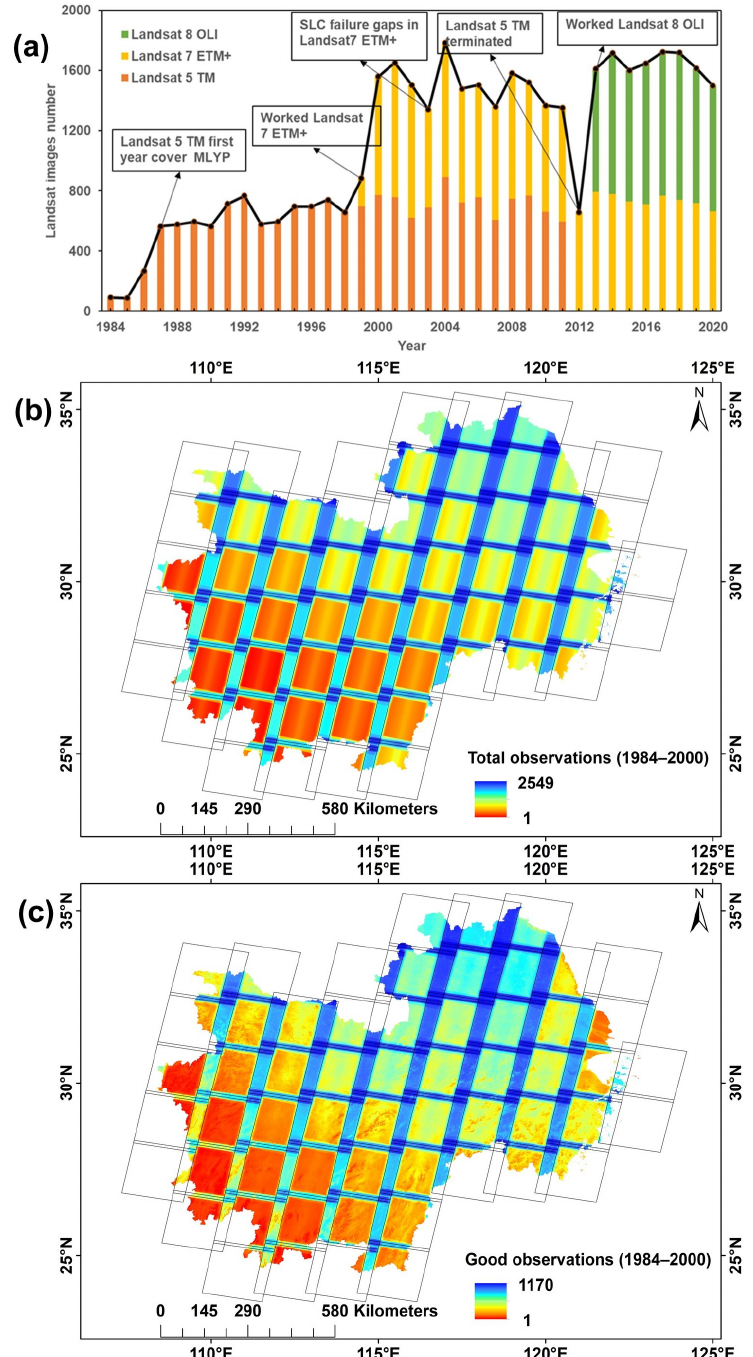
Figure 2. Landsat images used in this study: ( a ) number of scenes per year from different Landsat sensors; ( b ) spatial distribution of the total number of Landsat images; ( c ) spatial distribution of the number of good Landsat images.